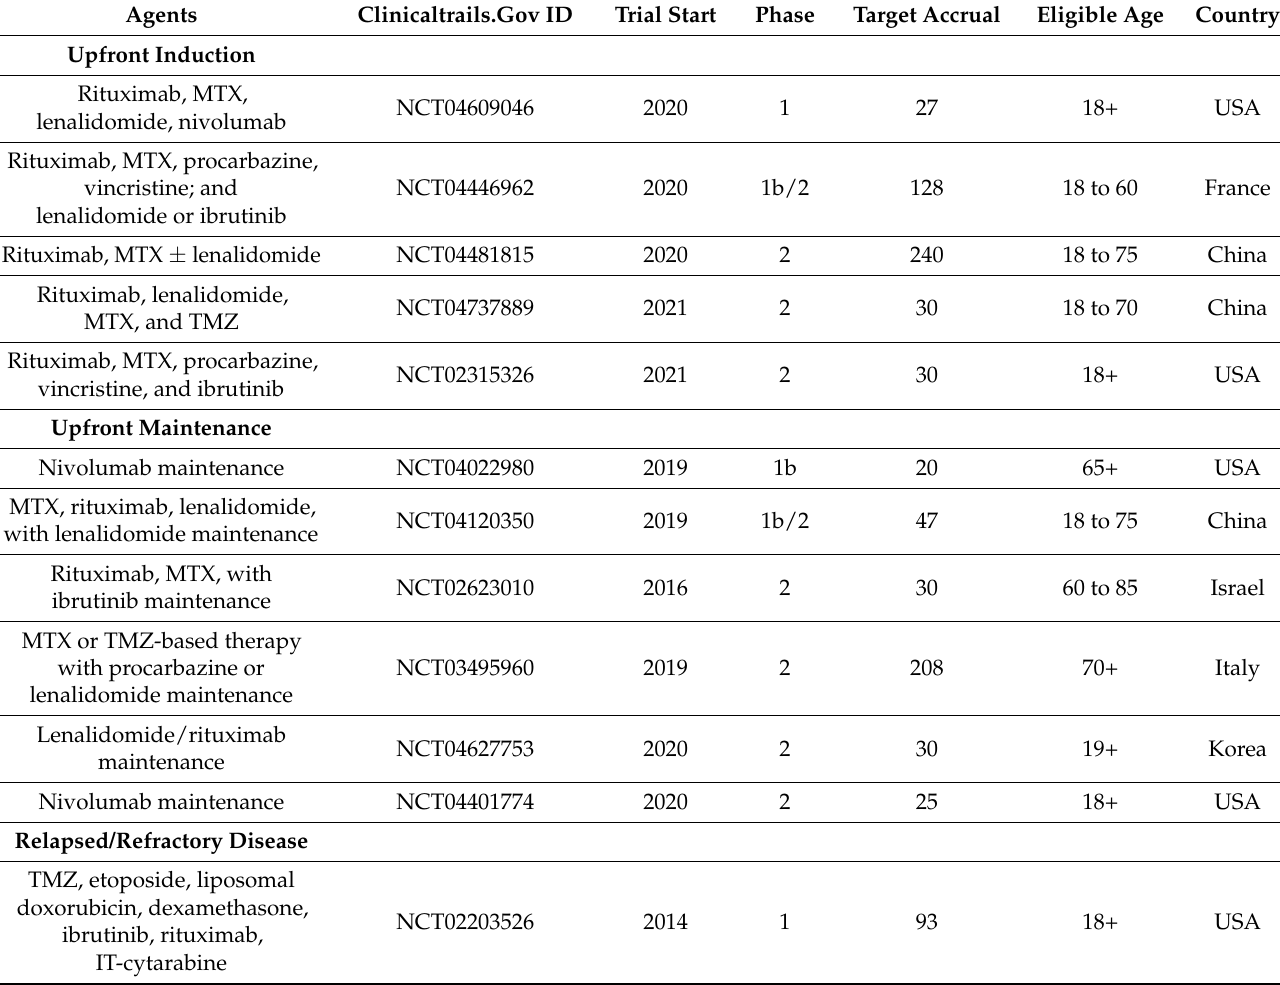
Table 2. Ongoing trials of novel